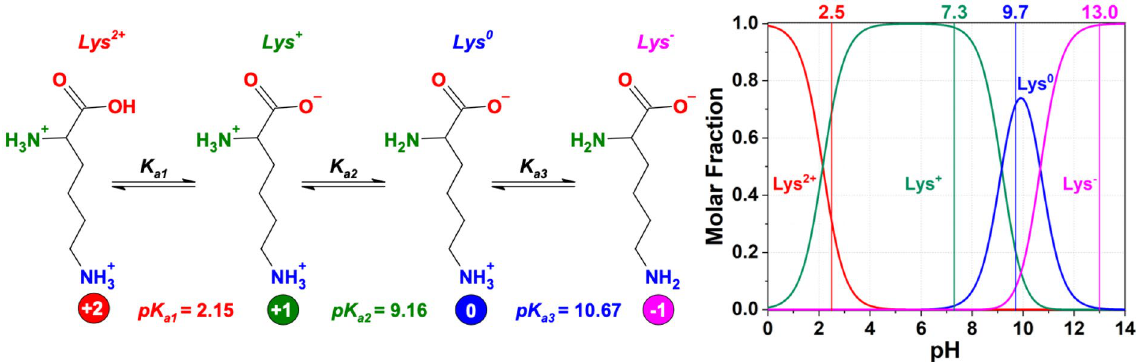
Figure 1. Charges of l-lysine as a function of pH. The data have been taken from references 15,16